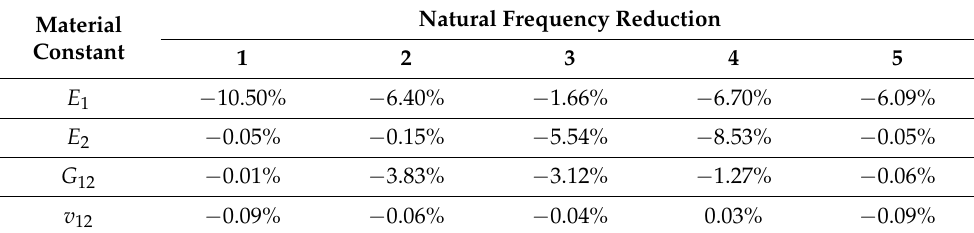
Table 8. Percentage changes in natural frequency induced by reductions in the material constants of a graphite/epoxy plate ( a / h = 120).